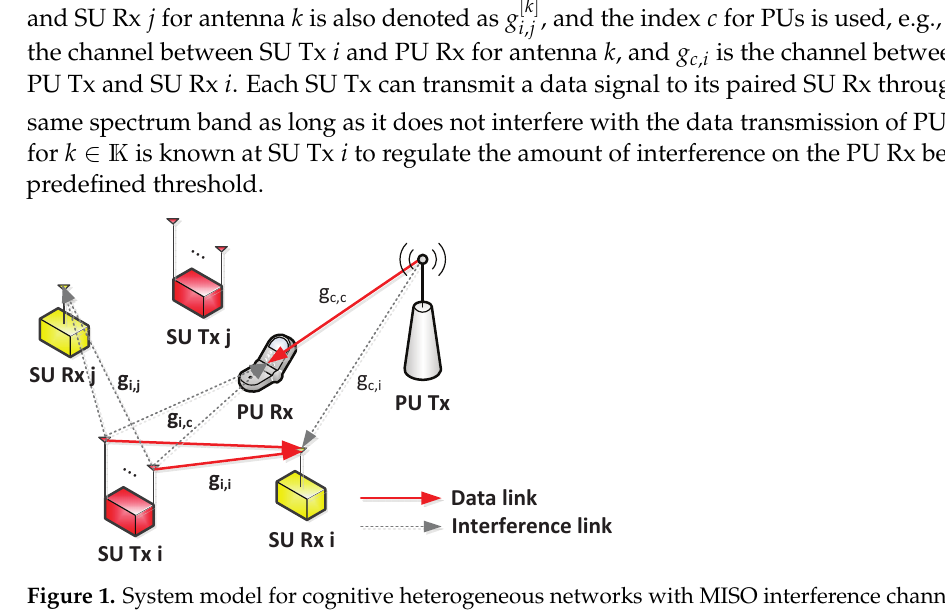
Figure 1. System model for cognitive heterogeneous networks with MISO interference